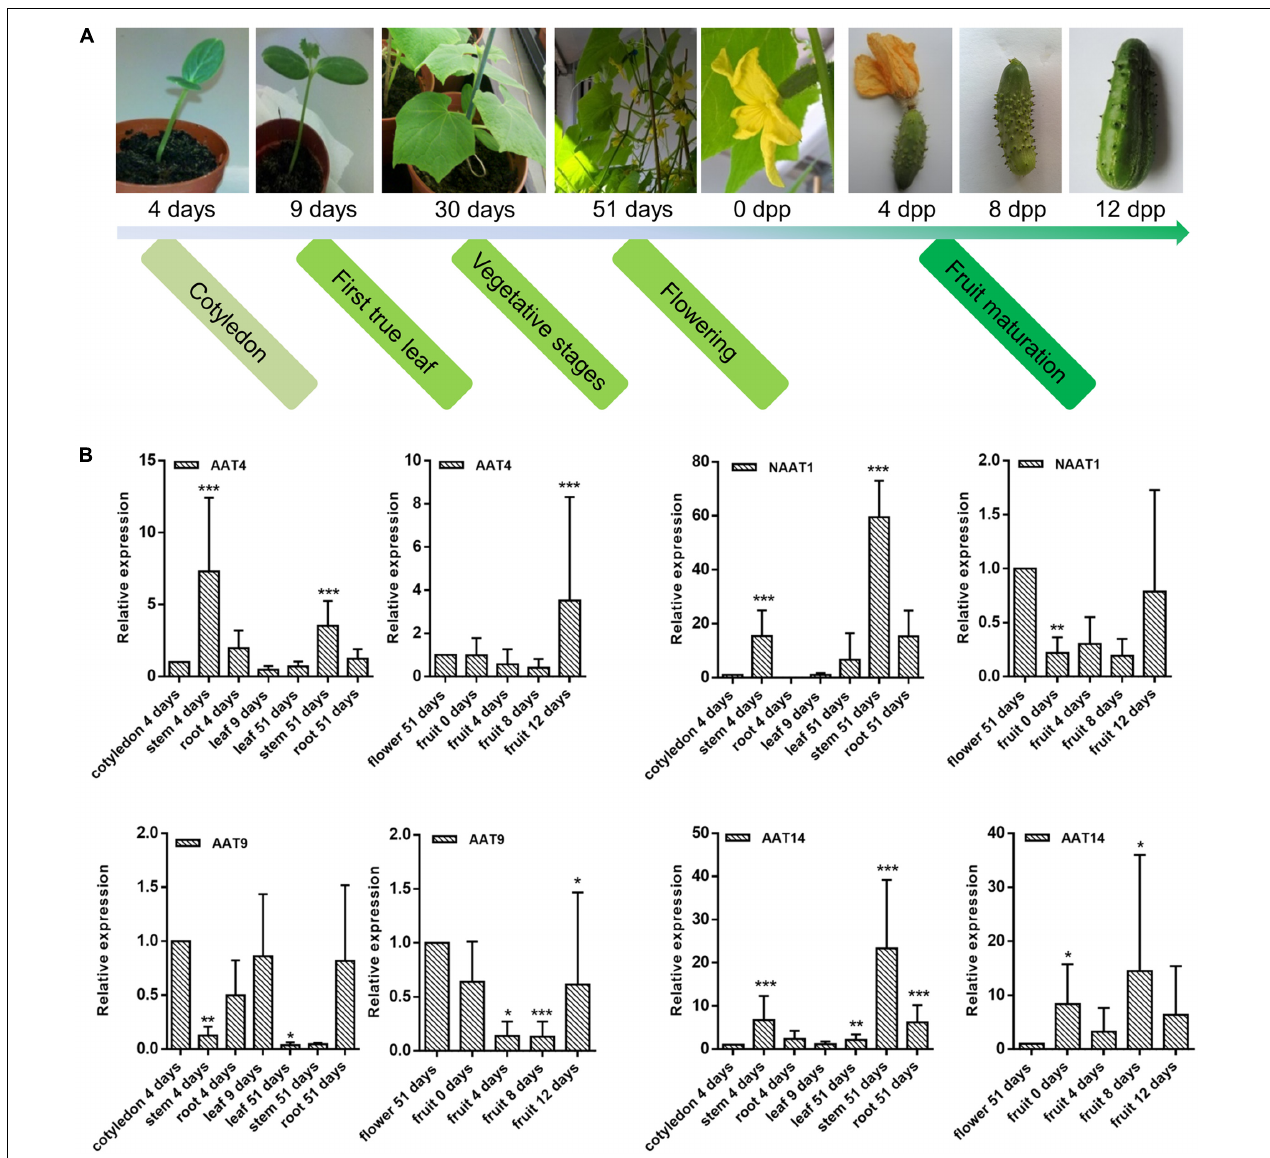
FIGURE 7 | Transcriptional profiling of AAT genes in different tissues during cucumber development. (A) Overview of development stages of cucumber plants for sample collections. (B) Relative expression levels of AAT genes from vegetative organs (leaves, stems, roots) are compared to the expression level in cotyledons while relative expression levels of AAT genes from reproductive organs (flowers and fruits) are compared to the expression level in flowers. Expression levels compared between cotyledon and flower: AAT4 (cotyledon):AAT4 (flower) = 1:0.8; NAAT1 (cotyledon):NAAT1 (flower) = 1:59.6; AAT9 (cotyledon):AAT9 (flower) = 1:0.14; AAT14 (cotyledon):AAT14 (flower) = 1:0.7. Expression levels compared between four AAT genes in cotyledon: AAT4:NAAT1:AAT9:AAT14 are approximately 1:0.01:1.49:0.04. Bars represent means and standard errors from two biological replicates, each replicate containing a pool of three plants. Asterisks indicated statistically significant differences compared with the control tissue ( ∗ p ≤ 0.05, ∗∗ p ≤ 0.01, ∗∗∗ p ≤ 0.001; REST